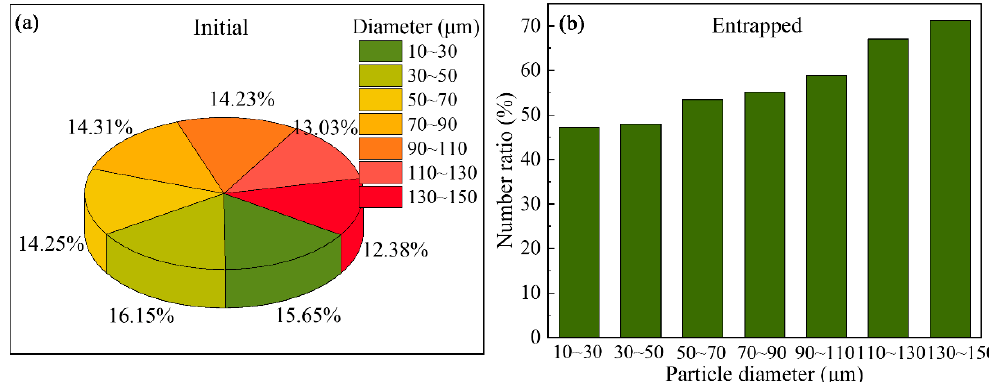
Figure 11. Number ratio of the grains with different diameters ( a ) at 0 s, ( b ) entrapped at 55 s.